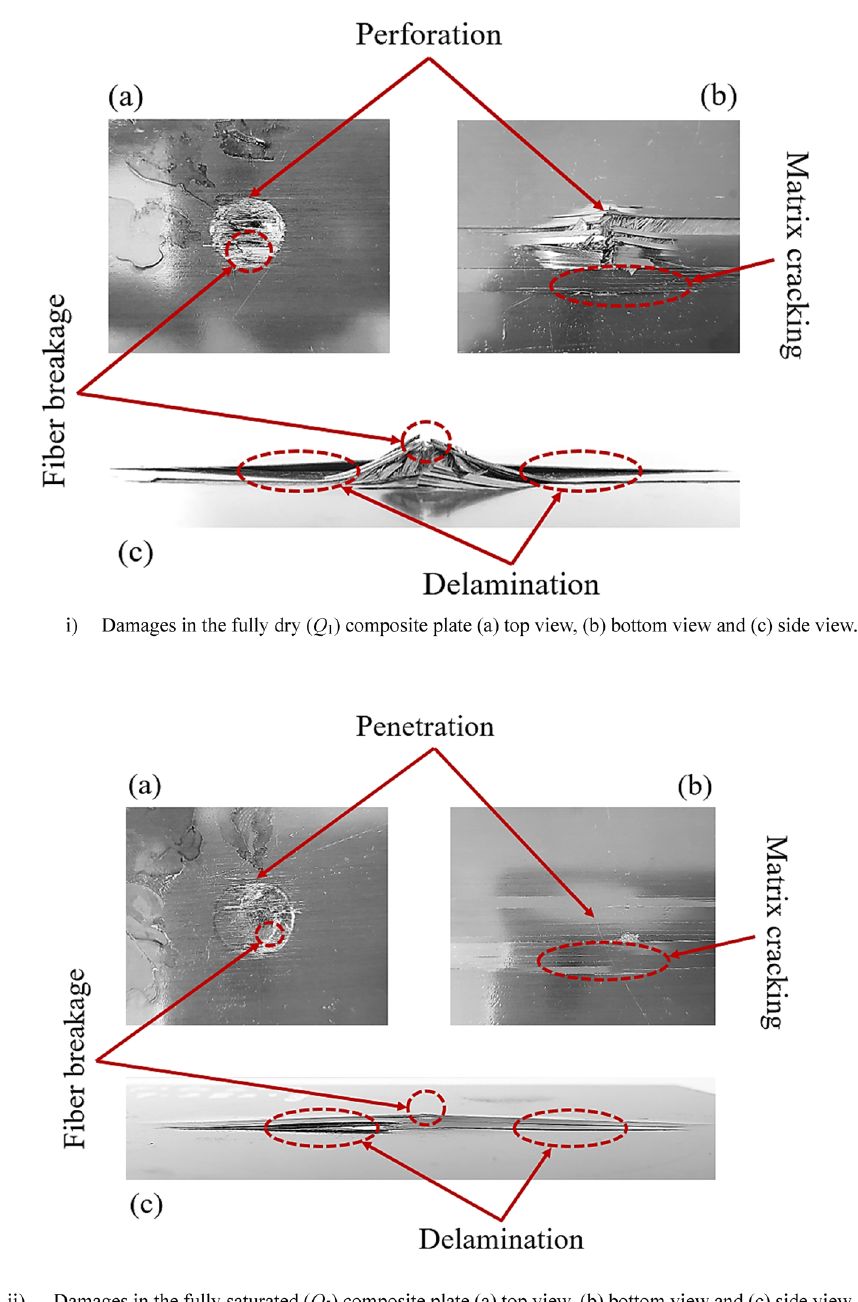
Figure 9. Different views of damages in (i) fully dry ( Q 1 ) and (ii) fully saturated ( Q 5 ) composite